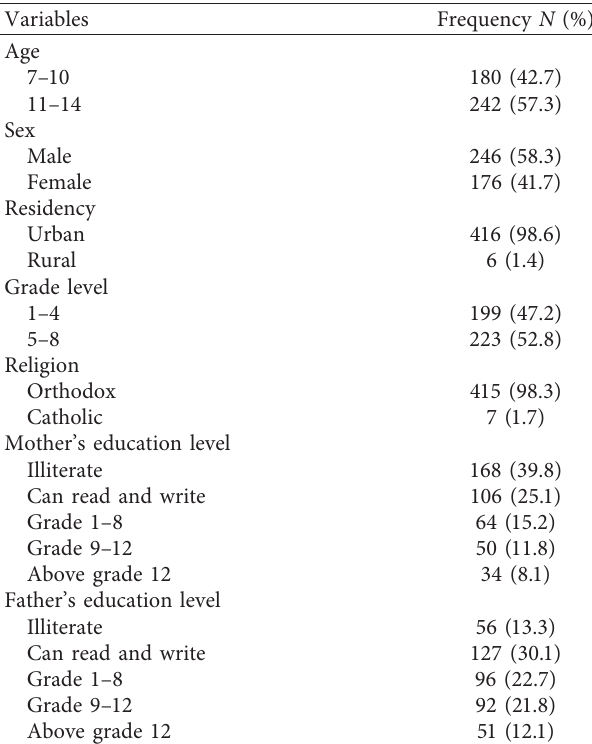
Table 3: Dietary- and oral hygiene-related characteristics of Alem Ketema Primary School children, North Shewa, Ethiopia,